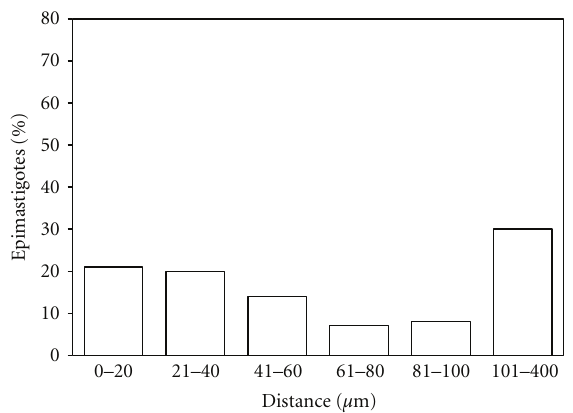
Figure 6: Analysis of flagellar rotational angle. The angles between two consecutive displacements were calculated for each parasite. The histogram is representative of the average behavior of 20 randomly selected epimastigotes.